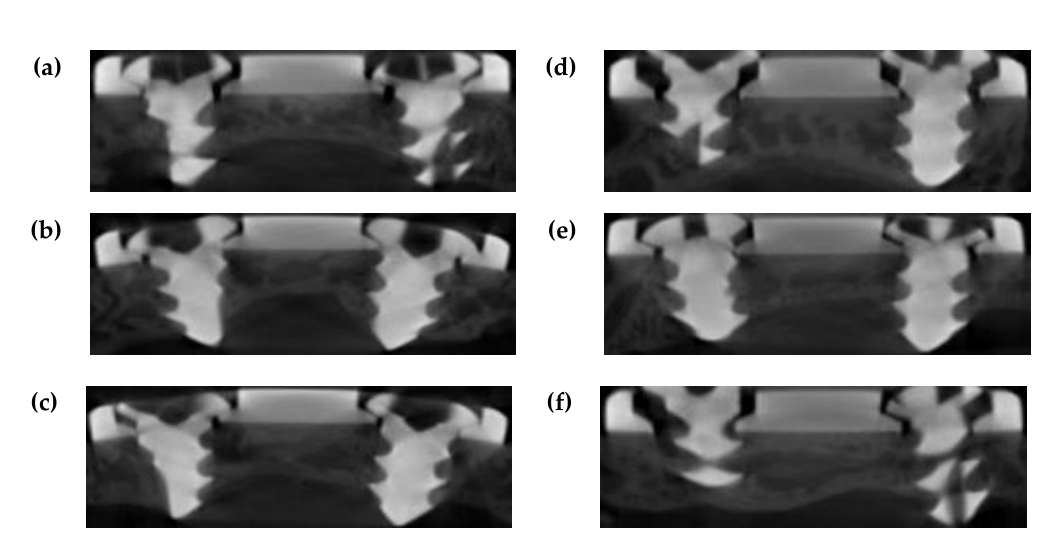
Figure 13. Comparison of the average percentage of new bone formation for each specimen in the animal experiment.